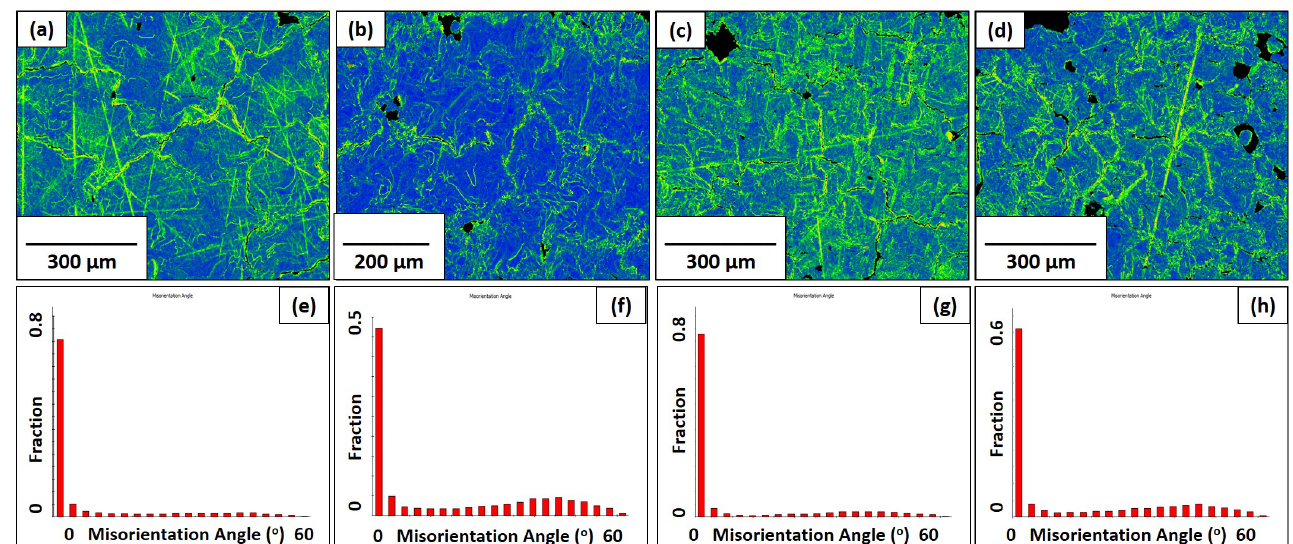
Figure 7. KAM maps for the Mo-0.1SiC specimens in the observation direction at all four scan speeds: ( a ) 100 mm/s; ( b ) 200 mm/s; ( c ) 400 mm/s; ( d ) 800 mm/s. Grain orientation spread graphs for the Mo-0.1SiC specimens in the observation direction at all four scan speeds: ( e ) 100 mm/s; ( f ) 200 mm/s; ( g ) 400 mm/s; ( h ) 800